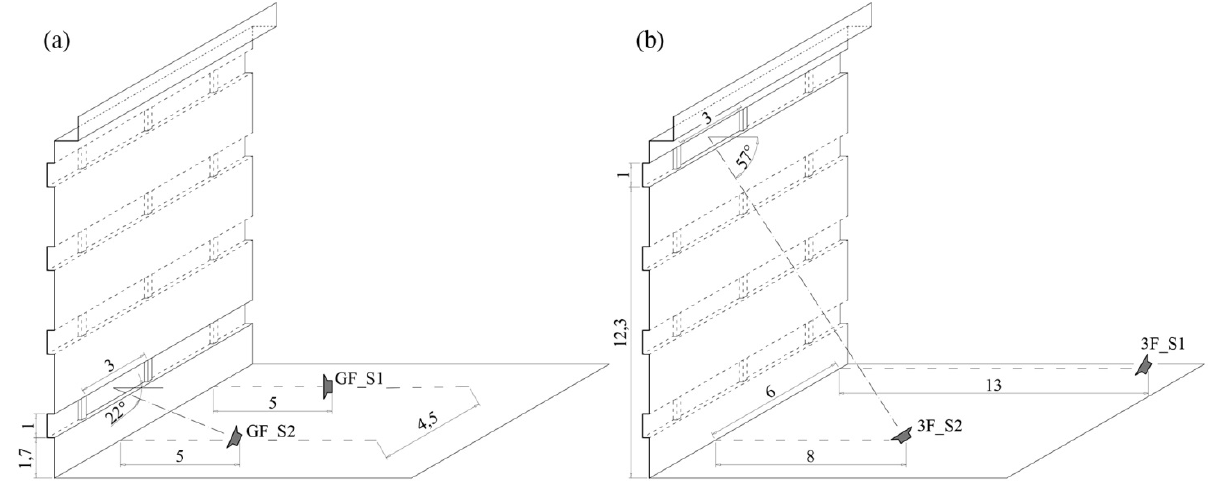
Figure 4. Scheme of source positions. ( a ) Source positions used on ground floor; ( b ) Source positions used on third floor. The “_ S1 ” positions were mainly used for the D 2m,nT measurements, while the “_ S2 ” positions were used to better evaluate the sound reduction provided by the shading system over the glazed surface. Both S1 and S2 positions were placed on the